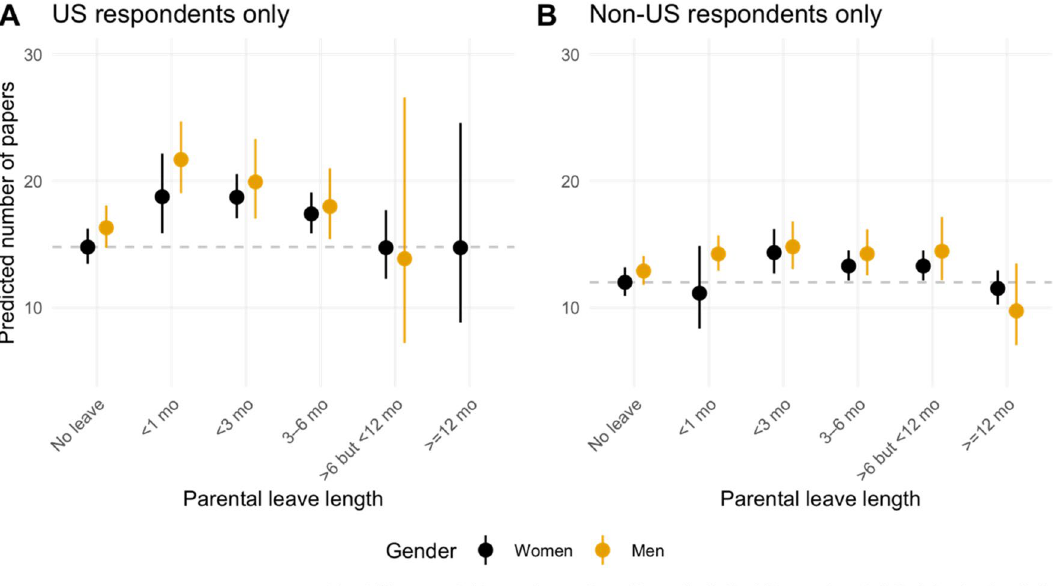
Figure 4. Predicted number of papers by parental leave lengths and gender in the (A) US sample and ( B ) Non-US sample. The dash line refers to the predicted productivity of our reference group: dual mothers with a non-academic partner taking no parental leave. Results are averaged over the levels of parenting type, partnership status, number of children, academic employment status, doctoral degree, and domain. Intervals are back-transformed from the log